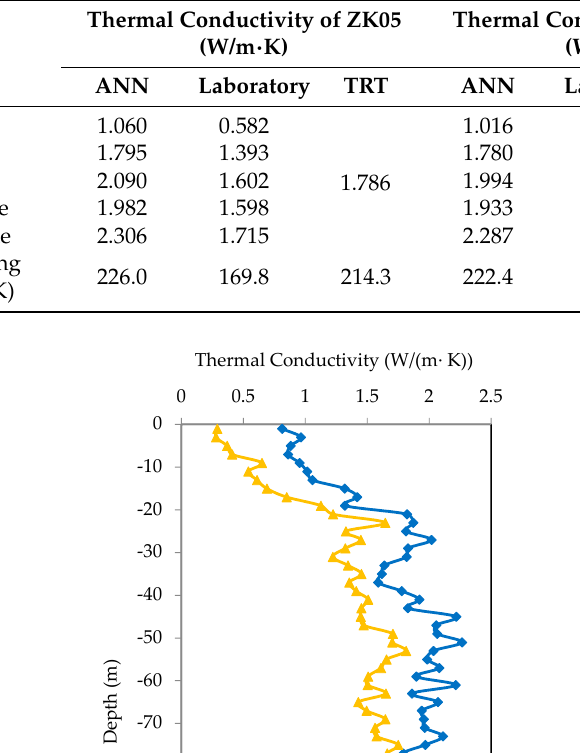
Table 4. Average layered thermal conductivity obtained by ANN models, laboratory test, and the standard TRT.